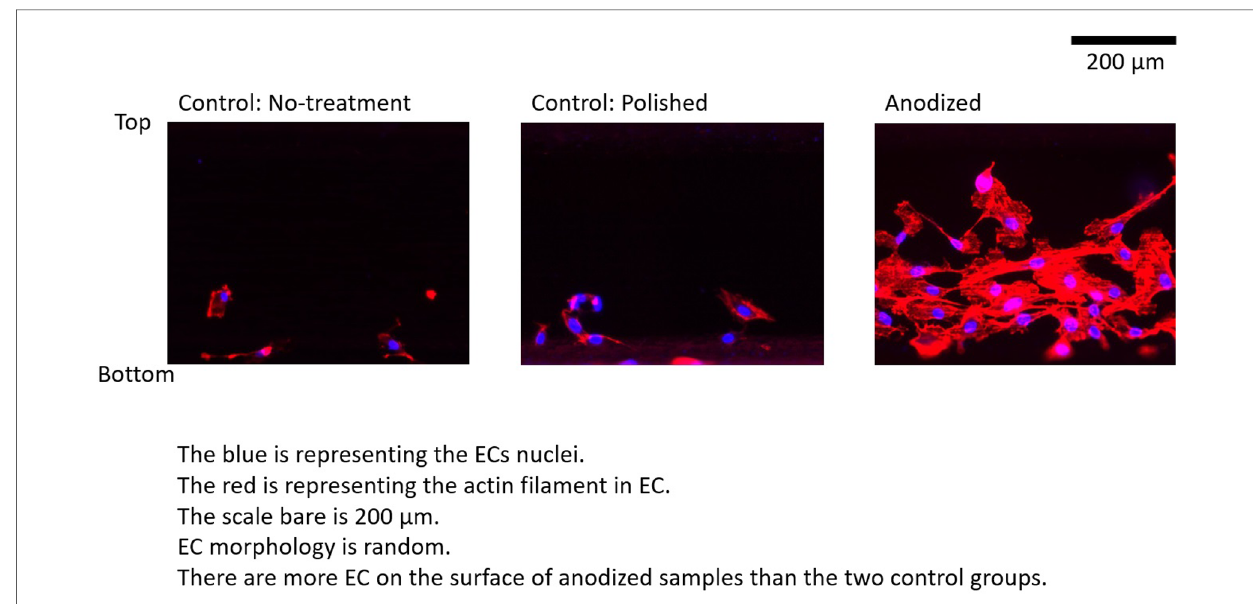
FIGURE 4 ECs on stent strut surfaces, without fl ow 24-h; blue color representing ECs nuclei; red color representing ECs actin fi lament; scale bar is 200 μ